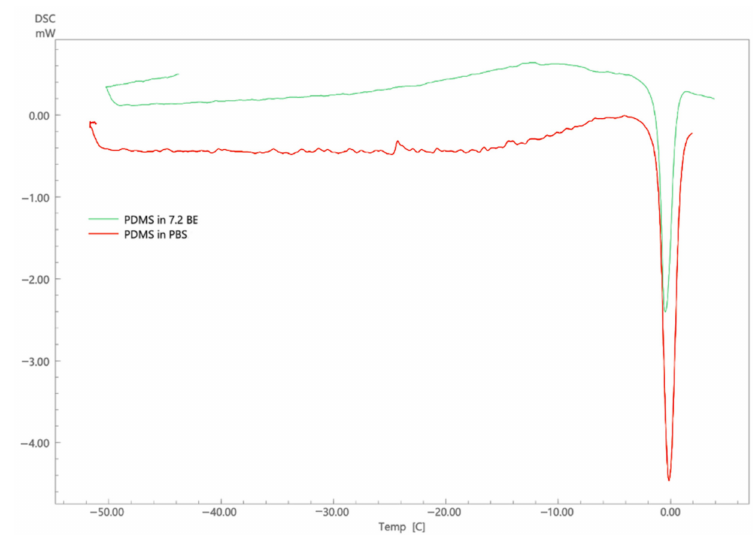
Figure 12. DSC thermogram of PDMS